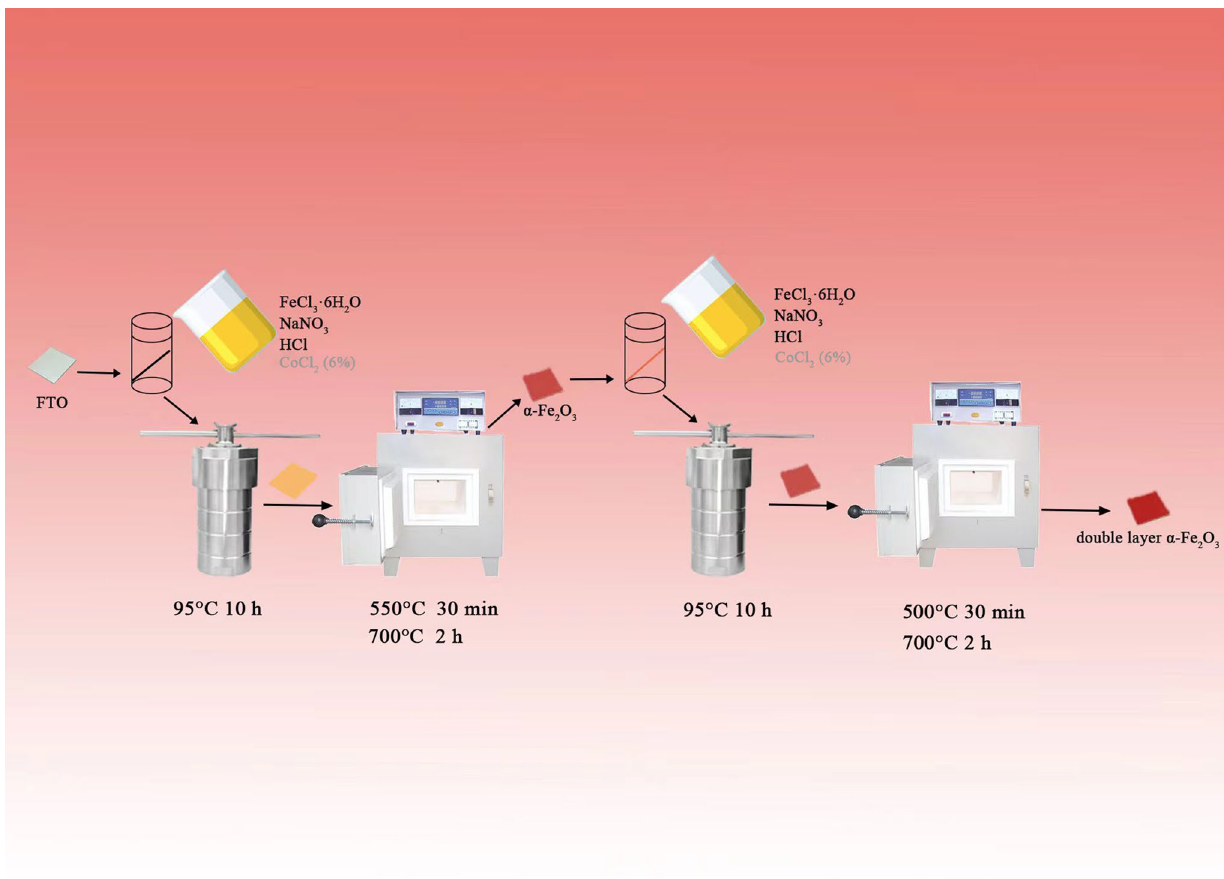
Fig. 1 Schematic preparation of α-Fe